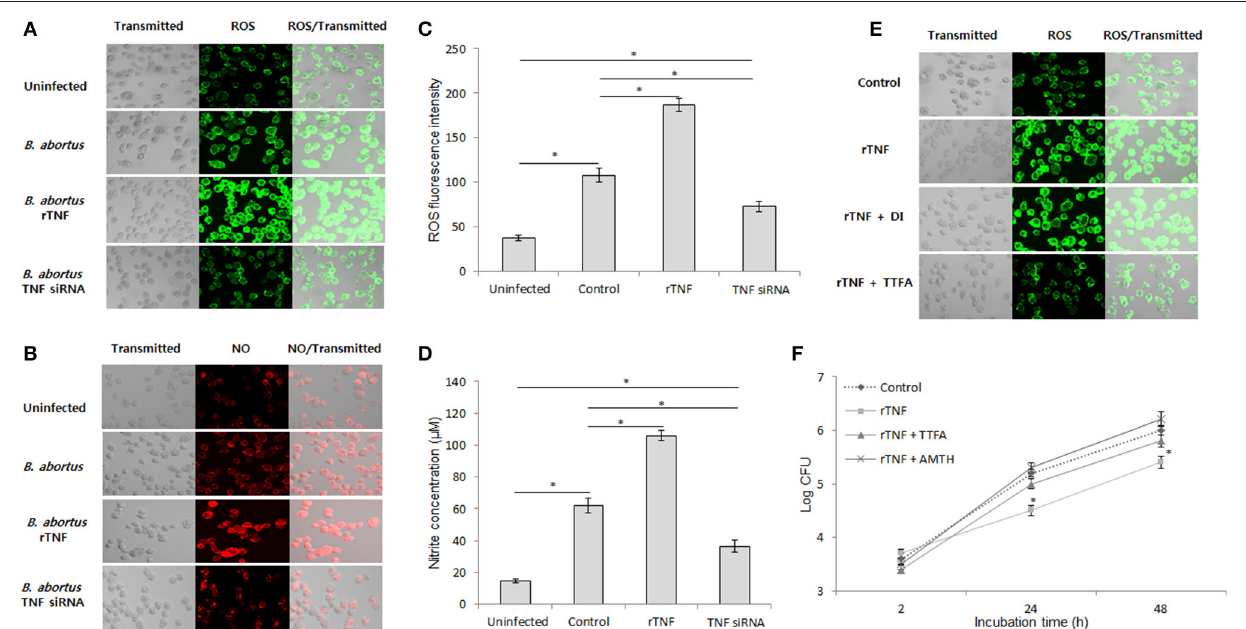
FIGURE 3 | TNF mediates mitochondrial ROS and NO to control intracellular B. abortus . Macrophages were treated with TNF siRNA prior to B. abortus infection. The accumulation of ROS (A) and NO (B) was evaluated by fluorescence microscopy. The cellular ROS (C) and the nitrite concentration in culture supernatant (D) were further confirmed at 24h post-infection by spectrometry assay and Griess reaction, respectively. To determine the source of ROS, the Brucella -infected cells were treated with either mitochondrial inhibitor (TTFA) or NADPH inhibitor (DPI), and the ROS production was checked by fluorescence microscopy at 24h pi (E) . The role of ROS and NO in TNF-induced protective immunity were examined by treatment of Brucella -infected cells with either TTFA or NOS2 inhibitor (AMTH). The intracellular growth of B. abortus was then evaluated (F) . Data represent the mean ± SD of triplicate experiments. Asterisk indicated the significant difference ( P < 0.05).